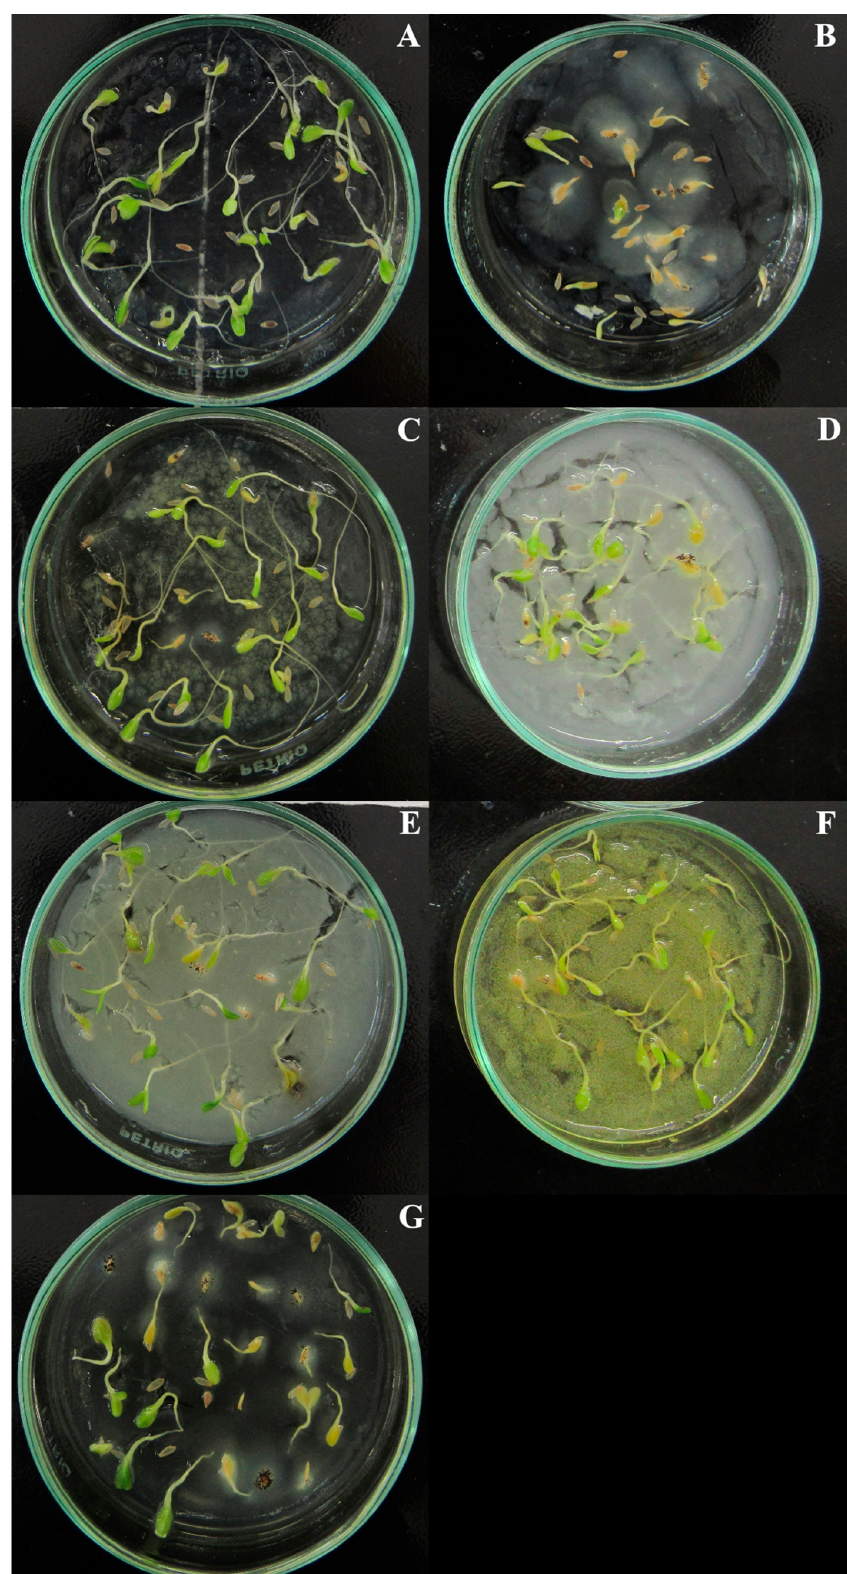
Figure 1. Lactuca sativa seedlings exposed to the six eugenol-derived coumarins at 800 µg.mL -1 concentration, on the 7th day after the start of the experiment: ( A ) agar + 8% Tween 80 (control); ( B ) A1; ( C ) A2; ( D ) A3; ( E ) A4; ( F ) A5; ( G ) A6.